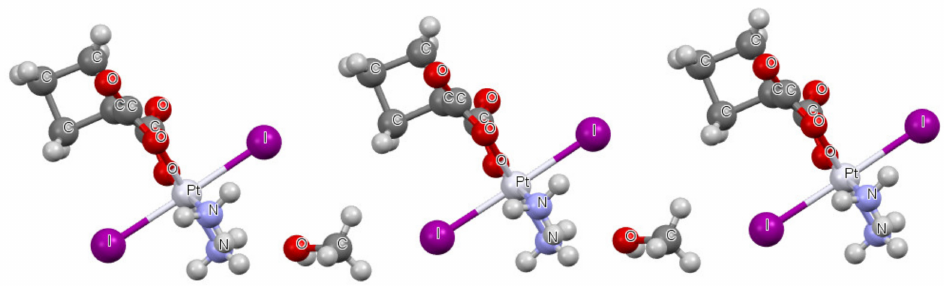
Figure 3. The fragment of the crystal structure of diammine-(cyclobutane-1,1-dicarboxylato)-di-iodo- platinum(iv) methanol solvate (QASKAX refcode); small grey circles correspond to H-atoms.